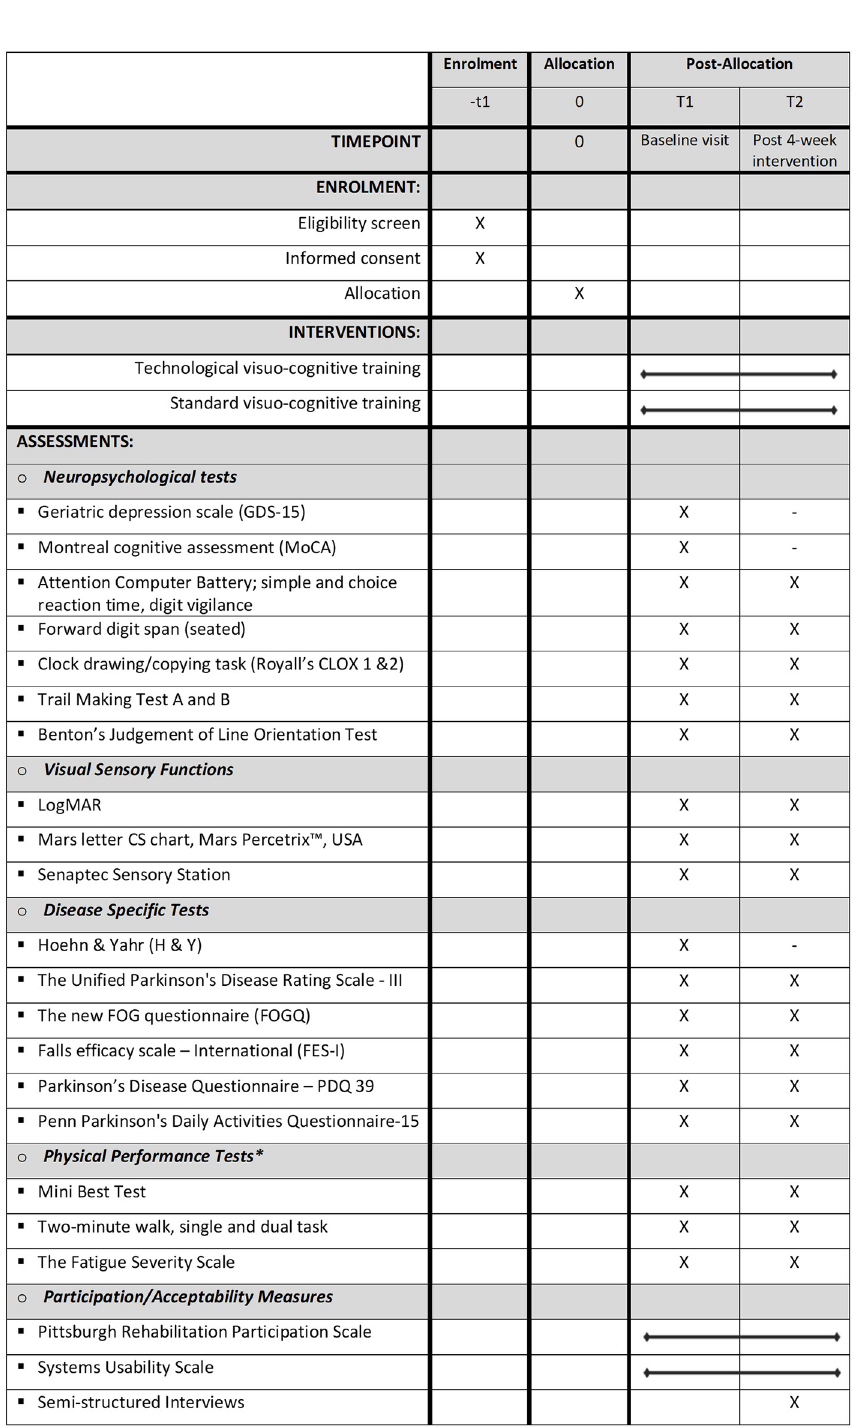
PLOS ONE | https://doi.org/10.1371/journal.pone.0275738 October 7,